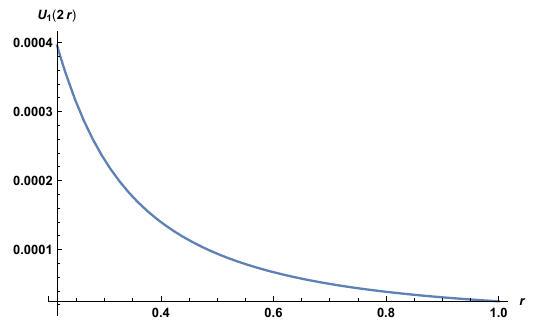
Figure 3 . The shape of the potential U (2 r ) with T 3 = 1, L = 0 : 01 and (cid:3) =